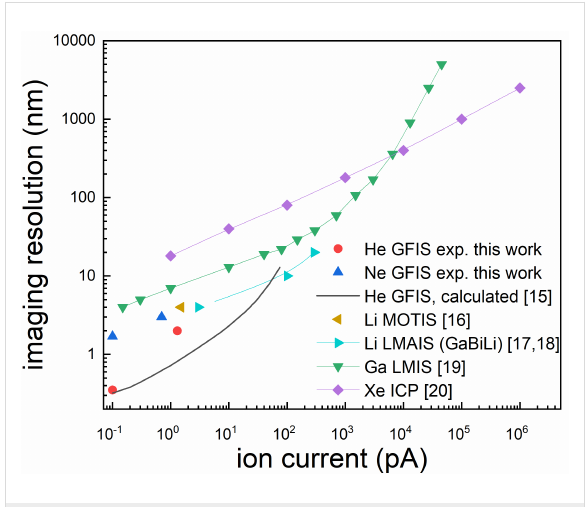
Figure 1: Comparison of the spot size (imaging resolution) as a func- tion of the ion beam current for different relevant FIB systems deter- mined theoretically [15] (r50) and from experiments using a 20% to 80% rise of intensity for He, Li [16-18], Ne, and Ga [19]. The beam size criterion for Xe [20] is